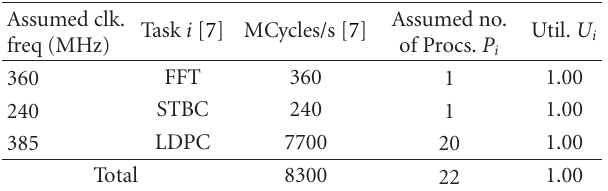
Table 4: Requirements of 4G baseband processing chain for 100Mbps data rate [7]. Assumed clk.